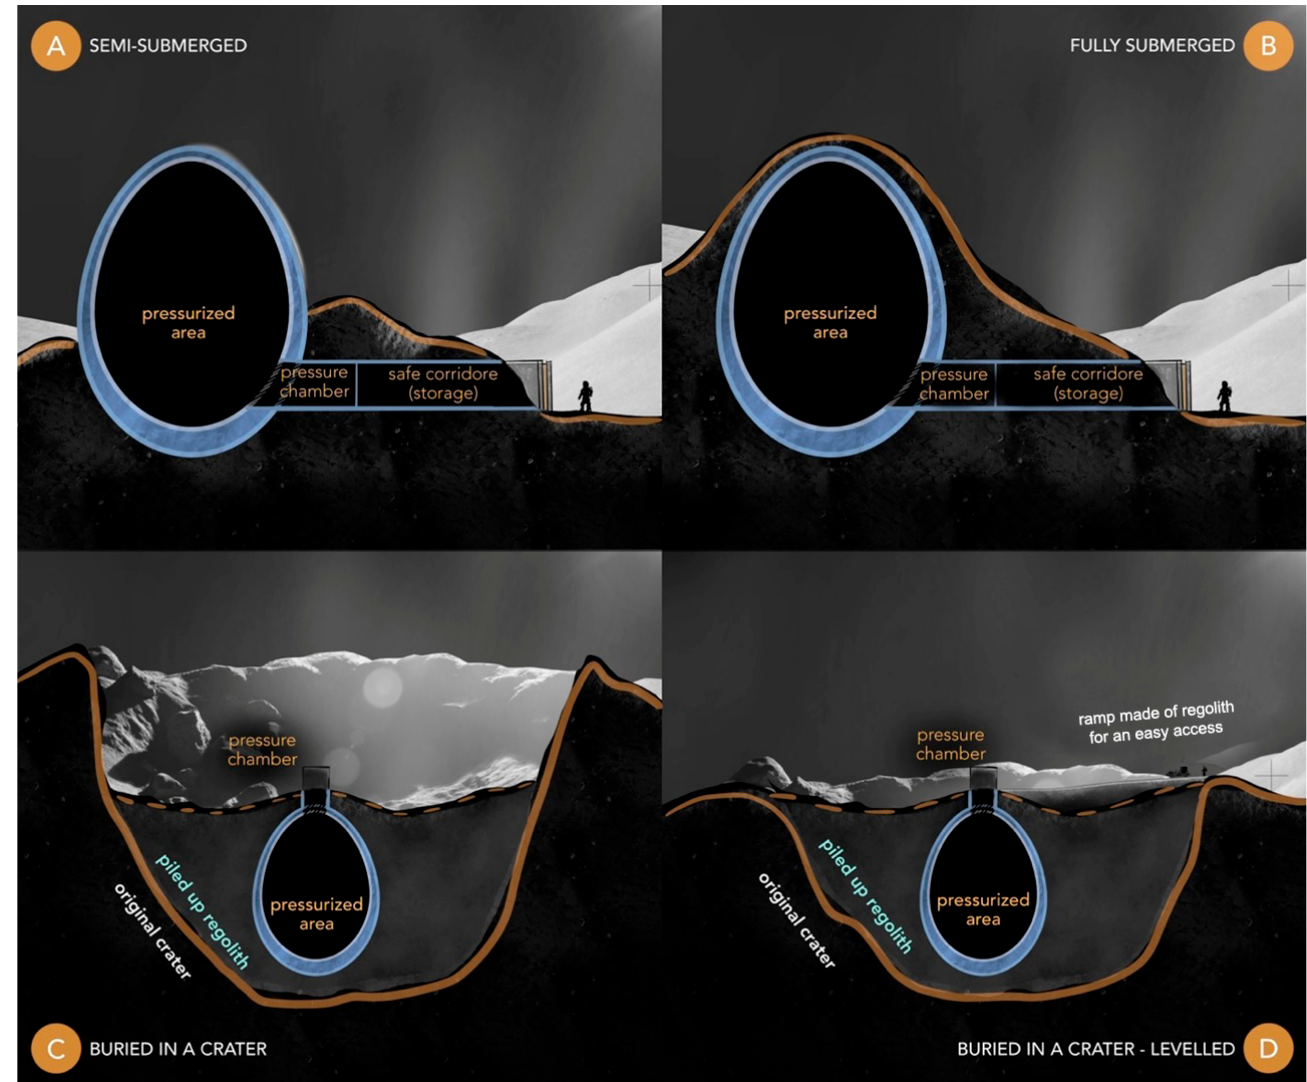
Figure 2. Concepts for placing an egg-shaped habitat on the surface of the Moon: cross-section view. ( A ) Semi-submerged, ( B ) fully submerged, ( C ) buried in a crater, ( D ) buried in a crater (levelled).